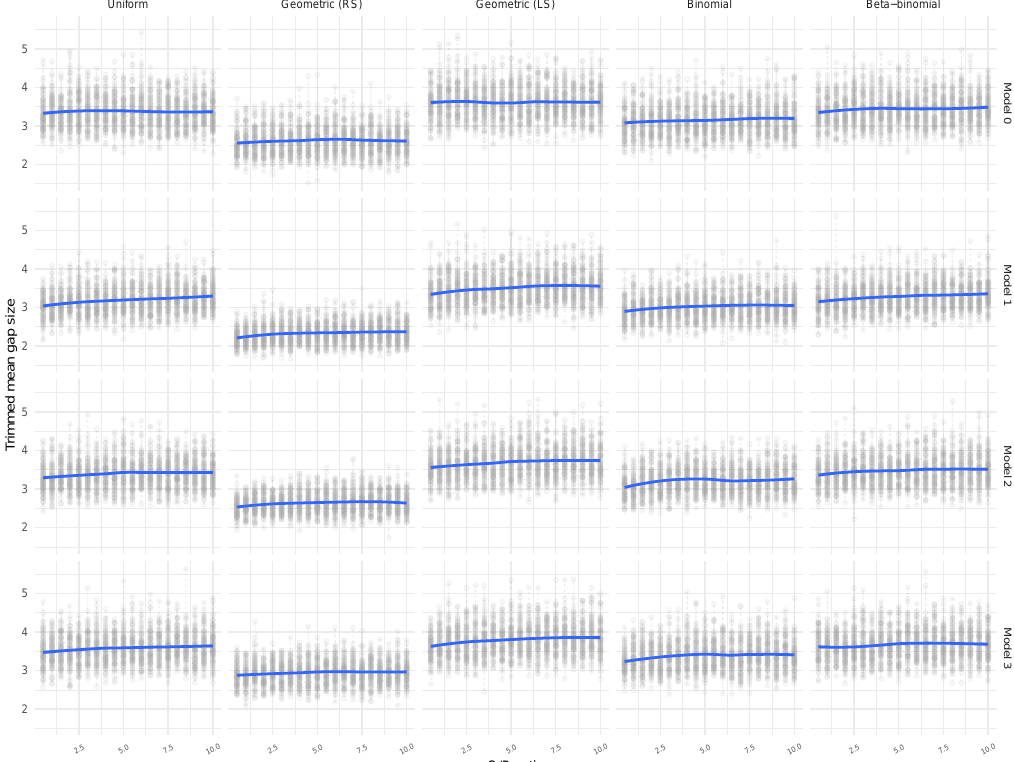
Figure 5. Loess tendency of the trimmed mean gap size for all O / R ratios differentiated by initial distribution of the rod lengths and all models characterized by the minimum gap d allowed in between two consecutive docking